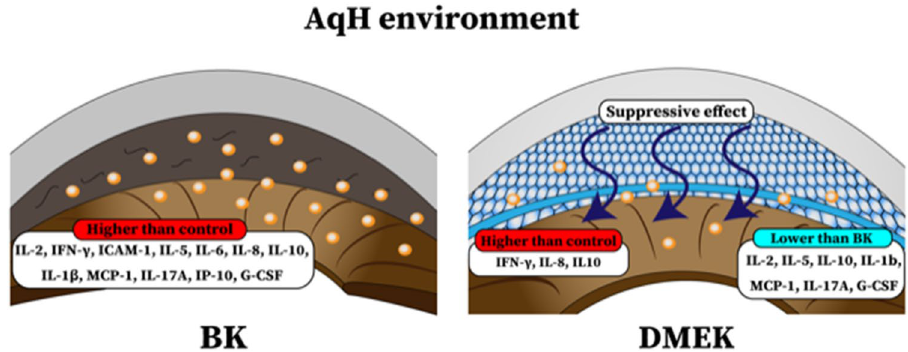
Figure 2. Cytokine concentrations in BK and DMEK eyes. ( a ) Eyes with bullous keratopathy (BK) show increased AqH concentrations of various inflammatory cytokines when compared with healthy eyes, possibly due to a lack of protective/suppressive effects of corneal endothelial cells (CEnCs). ( b ) After DMEK, cytokine levels are suppressed in eyes with BK, arguably by transplanted CEnCs, although levels of some cytokines